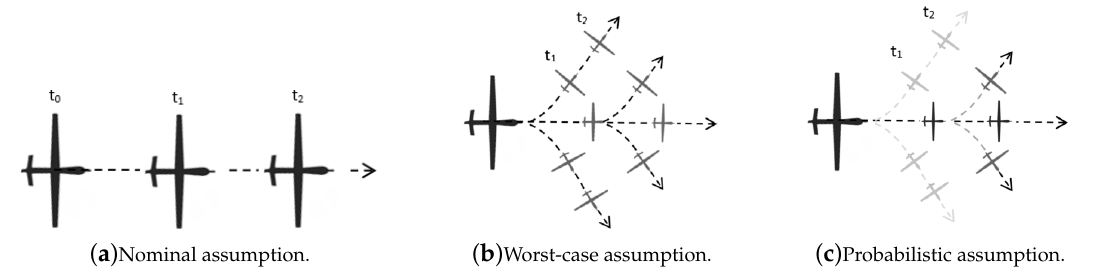
Figure 2. Different types of predictability assumption